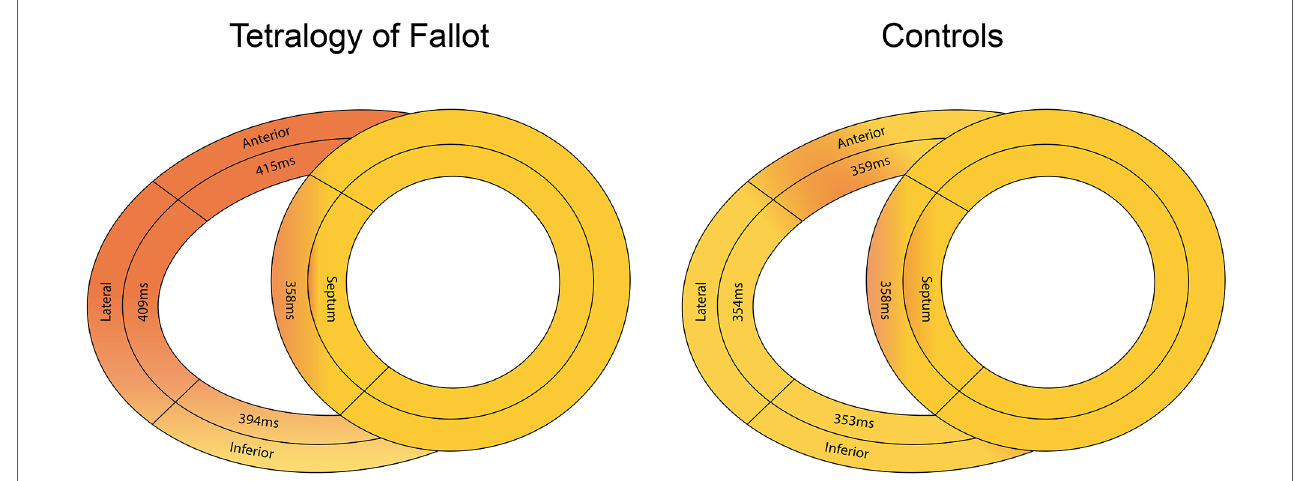
FIGURE 4 Differences in median time to peak longitudinal strain values across the basal right ventricular free wall and mid-septum in ToF patients (left panel) and healthy controls (right